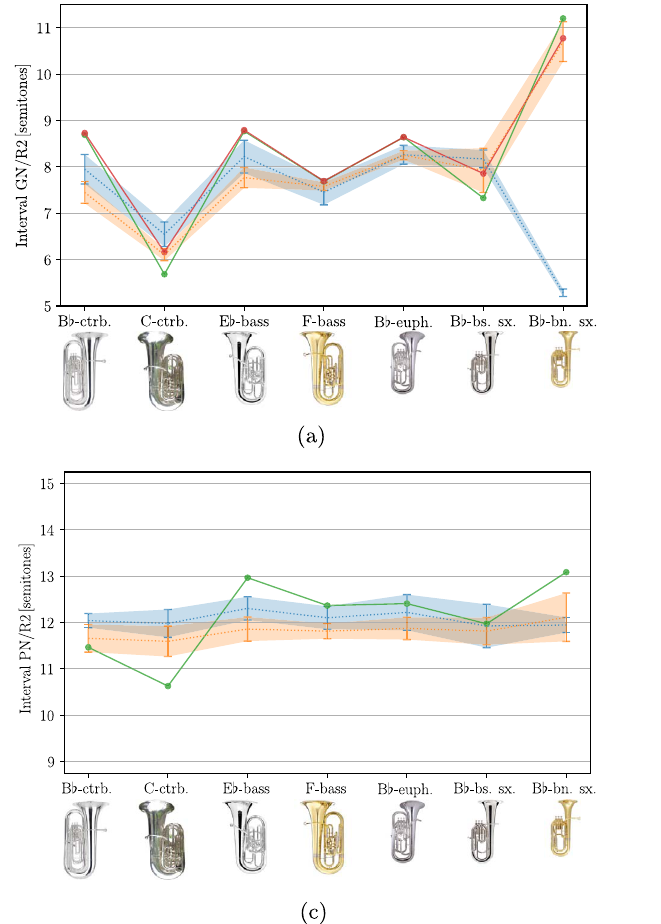
Figure 13. Frequency intervals with respect to type of tuba. Blue points: frequency interval inferred from the recording of the fi rst tuba player, orange points: frequency interval inferred from the recording of the second tuba player, green points: frequency interval inferred from the bifurcation diagrams, red points: frequency interval inferred from the linear stability analysis (when relevant). The instantaneous frequency (respectively the “ error ” bar) of a note is computed taking the average (respectively the standard deviation) of the frequency over the notes occurrences in the exercise – usually from 4 to 8 identical notes – of the average frequencies individually computed by Yin [34] in a permanent regime. (a) Ghost note/second regime. (b) Pedal note/ghost note. (c) Pedal note/second